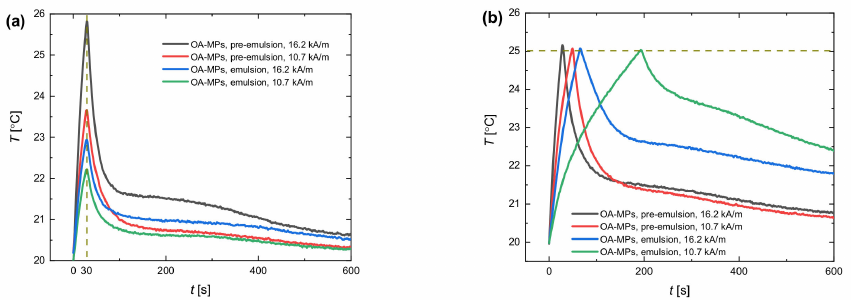
Figure 4. The temperature versus time for measurements under the AC magnetic field of the amplitude of 10.7 and 16.2 kA / m for pre-emulsions and stable emulsions stabilized with OA-MPs for the situation ( a ) when the induction heating system was turned o ff automatically after 30 s and ( b ) when the induction heating system was turned o ff automatically when the temperature was above 25 ◦ C. The curves represent the process of heating and the subsequent cooling down process due to the constant temperature in the thermostated container (20 ◦ C) after turning o ff the magnetic field. The mass concentration of silicone oil in relation to castor oil and the concentration of magnetite were the same for each of samples (10% and 2.3%, respectively). The results had uncertainty values of 1–5% that were not presented in the graph for better